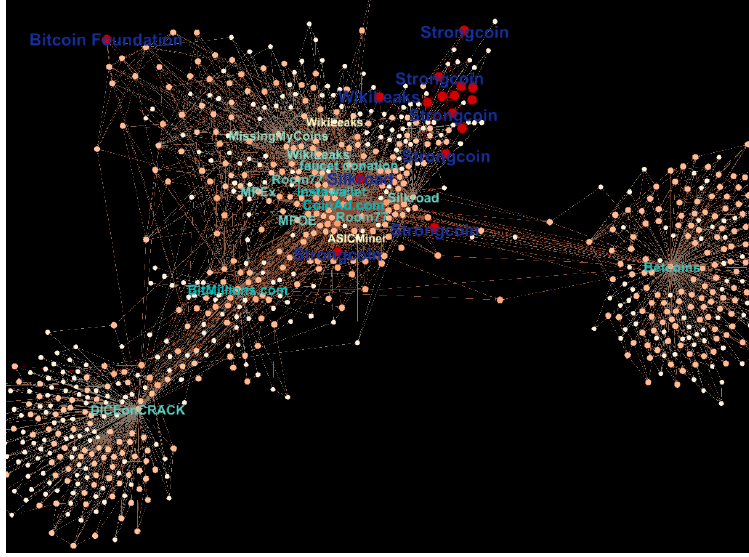
Figure 41. Closeness Centrality in the Bitcoin Network.